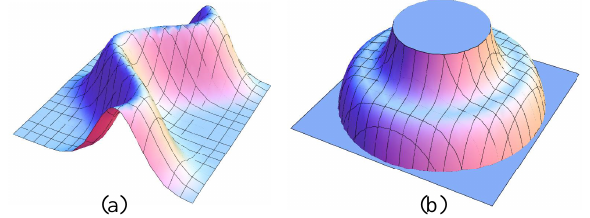
Fig. 1 Schematics of topologically different optimization landscapes. Reproduced with permission from Ref. [12], (cid:13) C 2015 APS. (a) The landscape has a low dimensional top level-set and no traps or saddles. (b) The landscape has a higher dimensional top level-set and saddle points, but no traps. Realistic quantum control landscapes typically are very high dimensional, and Fig. 1 is for illustrative purposes.